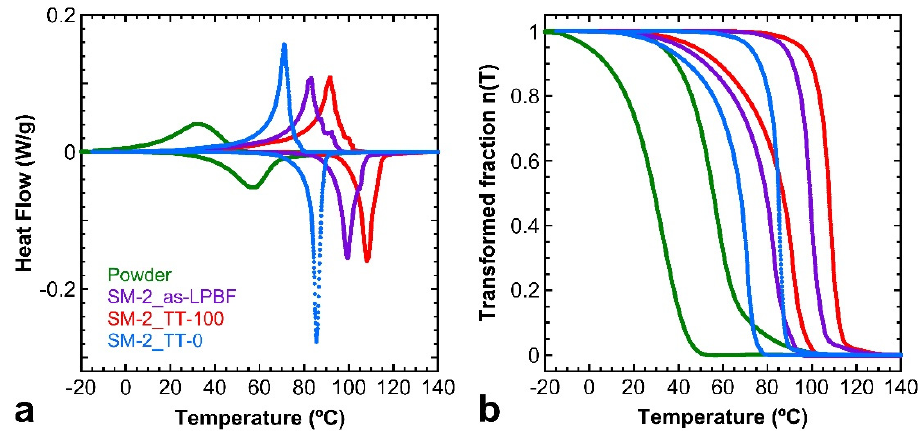
Figure 9. ( a ) DSC thermograms. ( b ) Transformed mass fraction curves. In both figures, different samples are compared: powder material (green curve), the as–LPBF sample SM–2 (violet curve), and after different thermal treatments, TT–100 (red curve) and TT–0 (blue curve). See text to correlate these curves with the different microstructural states.